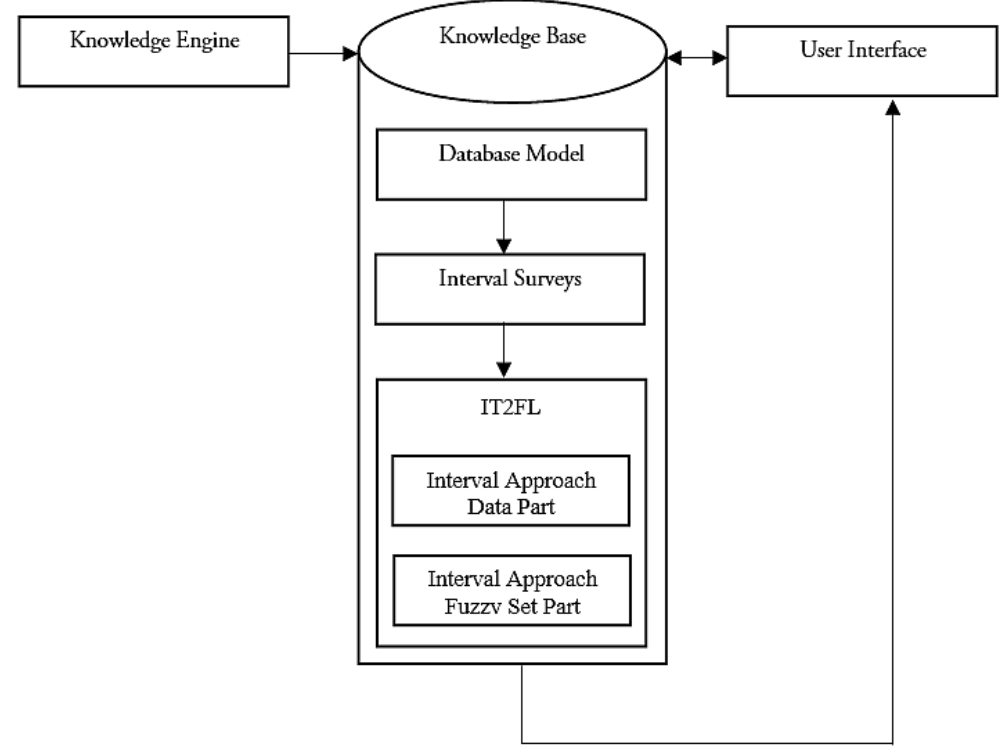
Fig. 4. Architecture for analyzing Igbo emotion words using interval